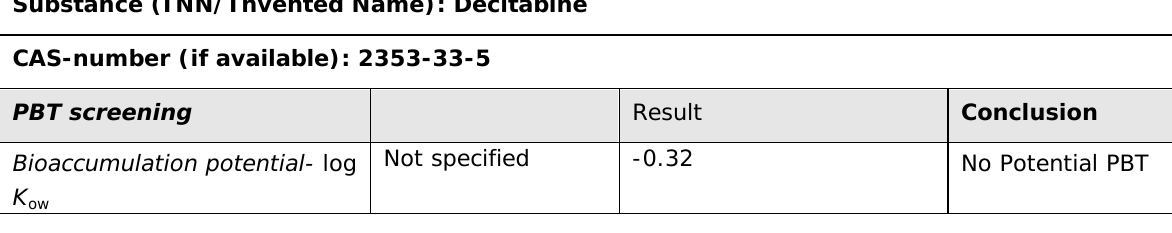
Table 13: Summary of main study results Substance (INN/Invented Name): Decitabine CAS-number (if available): 2353-33-5 PBT